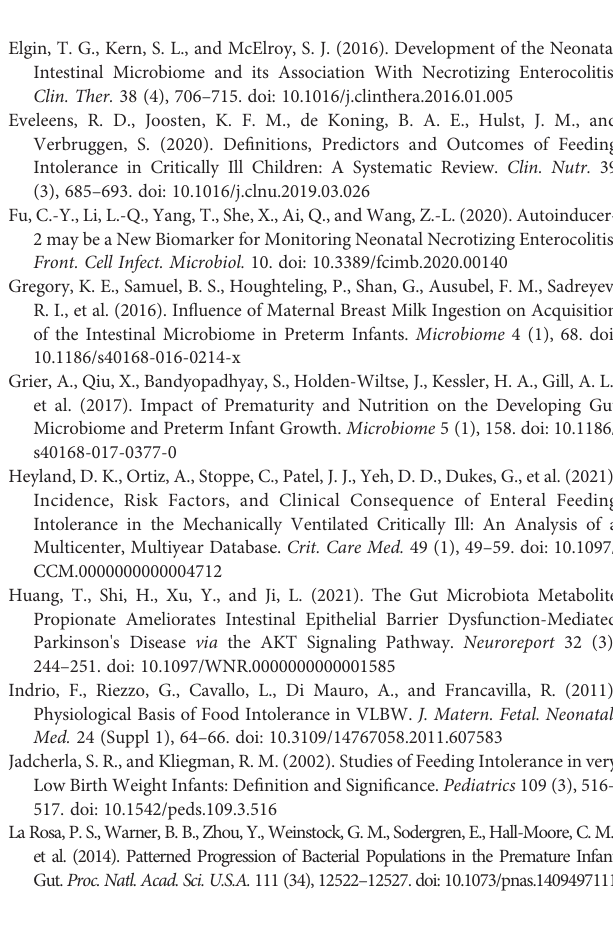
Supplementary Figure S1 | LEfSe of the microbiota in FI and FT groups. No communitiesfromphylumtogenusweresigni fi cantlydifferentbetweenthetwogroupsat2 weeksafterbirth(LDAscorelessthan4) (A) .Fourcommunitiesfromphylumtogenuswere signi fi cantlydifferentbetweenthetwogroupsat4weeksoflife(LDAscoremorethan4) (B) . Supplementary Figure S2 | LEfSe of the microbiota at 2 and 4 weeks of life. In the FT group, seven communities from phylum to genus at 4 weeks were signi fi cantly different from those at 2 weeks (LDA score more than 4) (A) . In the FI groups, no communities from phylum to genus at 4 weeks were signi fi cantly different from those at 2 weeks (LDA score less than 4) (B) . Supplementary Figure S3 | Relationship between the gut microbiota and SCFAs. The change in color re fl ects the data in the two-dimensional matrix. The color depth indicates the size of the value, and it can intuitively express the size of the value in a de fi ned color